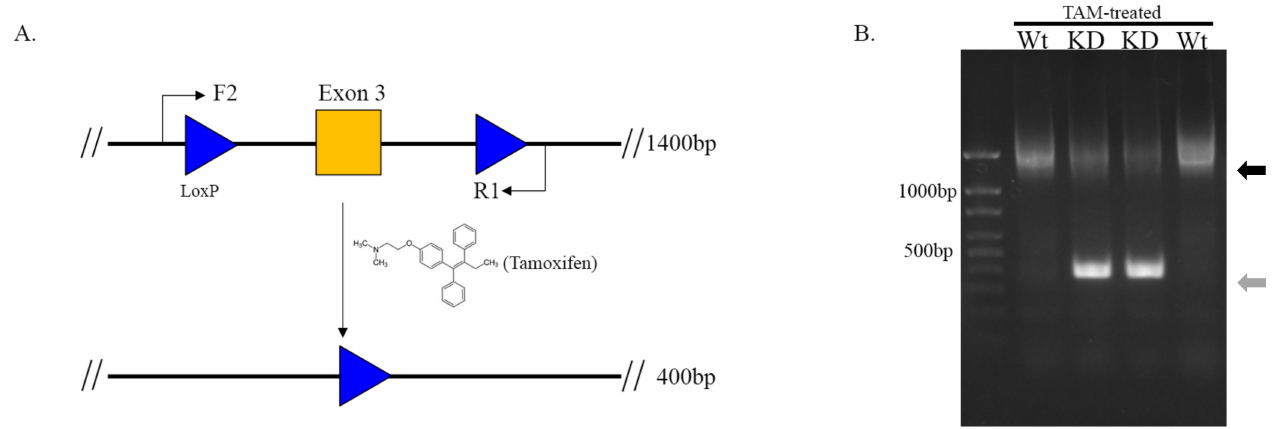
Figure 4. Administration of tamoxifen cleaves exon 3 of floxed SLMAP gene by activating α MHC-MerCreMer in mouse hearts. ( A ) Schematic representing cleavage of exon 3 in a KD mouse after treatment with tamoxifen. ( B ) PCR genotyping of hearts treated with tamoxifen (TAM) using primers F2/R1. Wt lanes indicate unaltered SLMAP, which results in a 1400 bp band. KD lanes result in two bands being present, a cleaved SLMAP band (400 bp; grey arrow) and an unaltered SLMAP gene (1400 bp; black